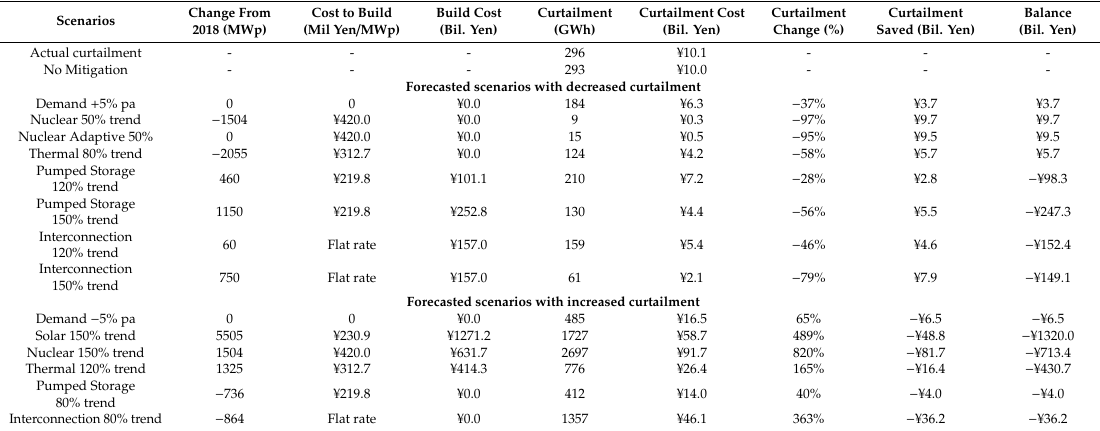
Table 7. E ff ects of mitigation